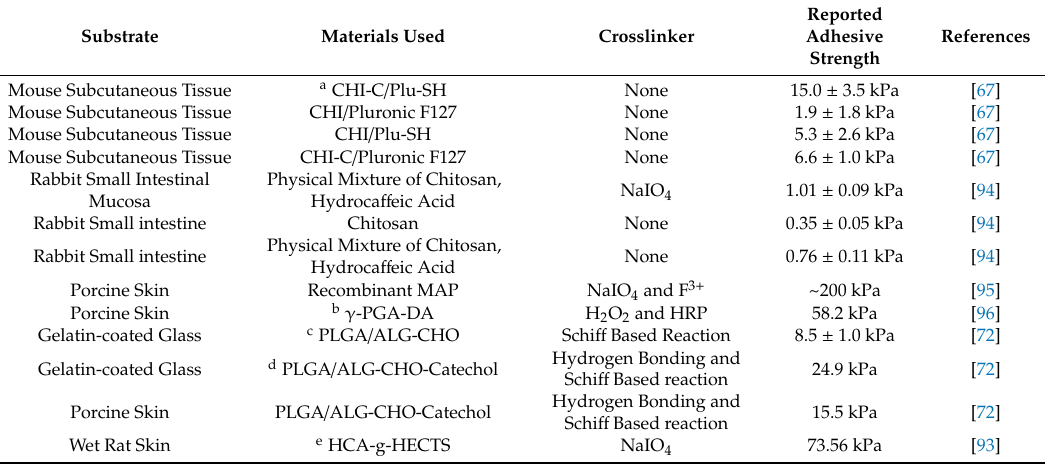
a CHI = chitosan, CHI-C / Plu-SH = catechol-functionalized chitosan / thiol-terminated pluronic F-127. b γ -PGA = Poly( γ -glutamic acid), DA = dopamine. c PLGA = adipic dihydrazide-modified ploy(L-glutamic acid), ALG-CHO = aldehyde-modified alginate. d ALG-CHO-Catechol = catechol- and aldehyde-modified alginate. e HCA = hydroca ff eic acid, HECTS = hydroxymethyl